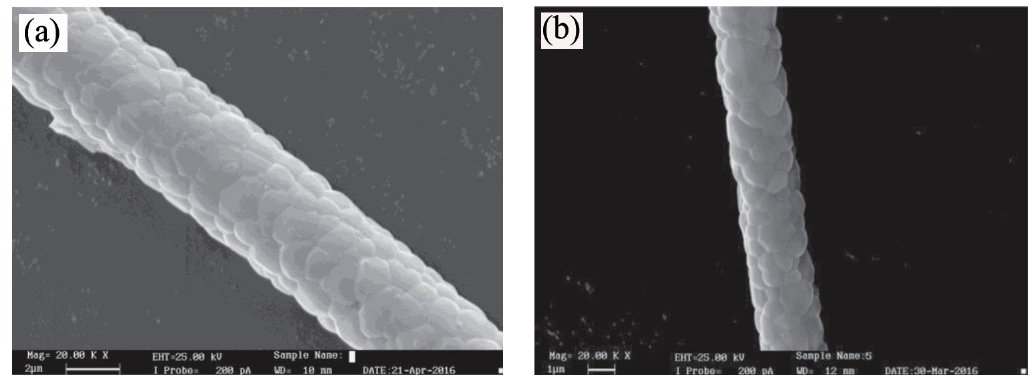
Figure 11. SEM microstructures of ( a ) YAG and ( b ) Cr-YAG precursor gel fibers heated at 1600 °C for 2 h and 6 h, respectively [86].